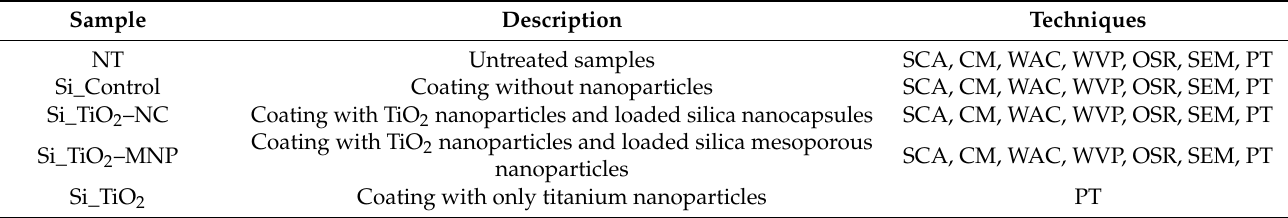
Table 2. Analyzed samples and applied characterization